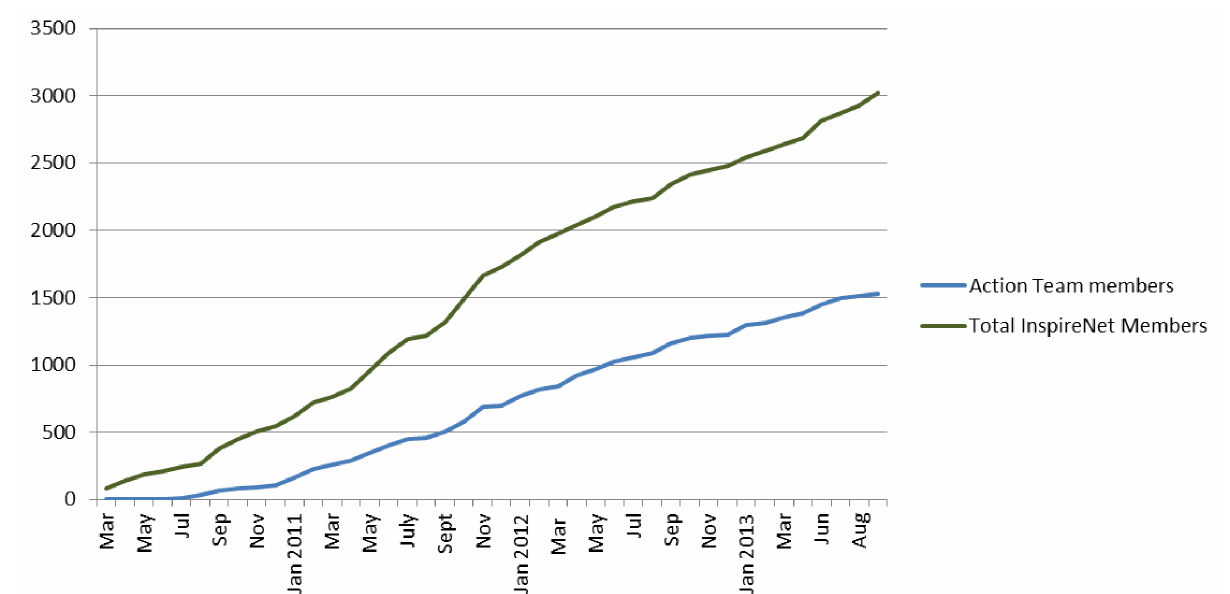
Figure 4. Action Team membership in relation to overall